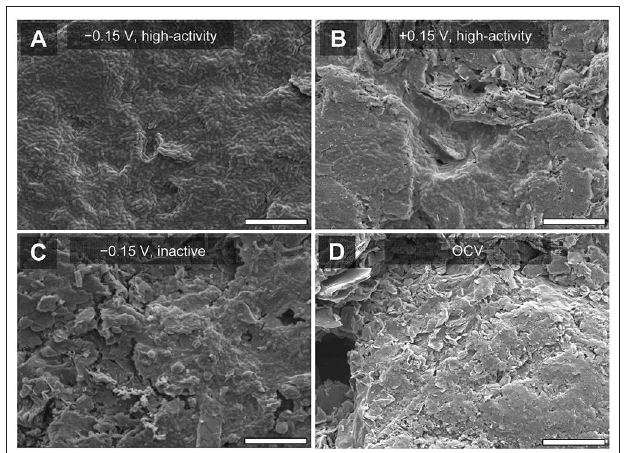
FIGURE 5 | Scanning electron microscopy (SEM) images of bioanodes at the end of the startup cycle. (A) High-activity bioanode at − 0.15V showing uniform and complete surface coverage of microorganisms, (B) high-activity bioanode at + 0.15V with similar cell morphology as (A) , but less surface coverage, (C) low-activity bioanode at − 0.15V, with mixed cell morphology and lower coverage relative to (A) , and (D) bioanode at open circuit voltage (OCV). White bar at the bottom of each figure represents a distance of 10 µ m.